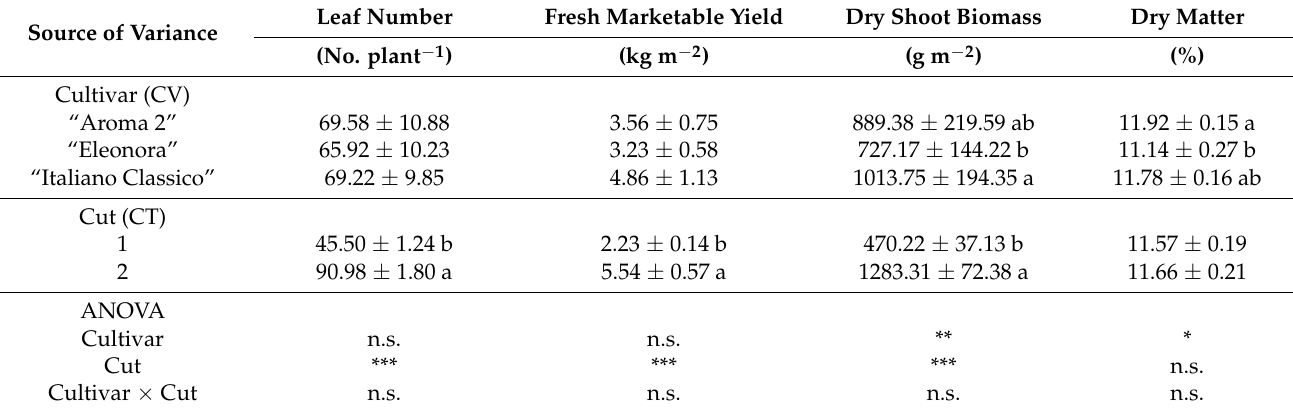
Table 1. Effect of cultivar and cut on leaf number, fresh marketable yield, dry shoot biomass, and dry matter of basil. Source of